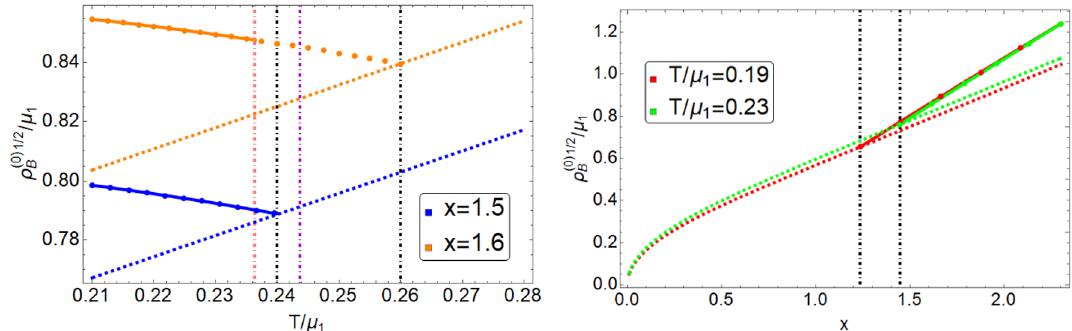
Figure 16 . The charge density ρ (0) in the presence of CDW as the function of temperature T (left) B and doping parameter x(right). The solid curves in color stand for ρ (0) in SSC phase, while the B dotted curves in color stand for ρ (0) in the absence of CDW, and the dashed lines in color stand for B ρ (0) in RN black hole. The vertical lines in black denote the location of the critical temperature of B SC, and the vertical lines in pink or purple denote the location of the critical temperature of CDW.